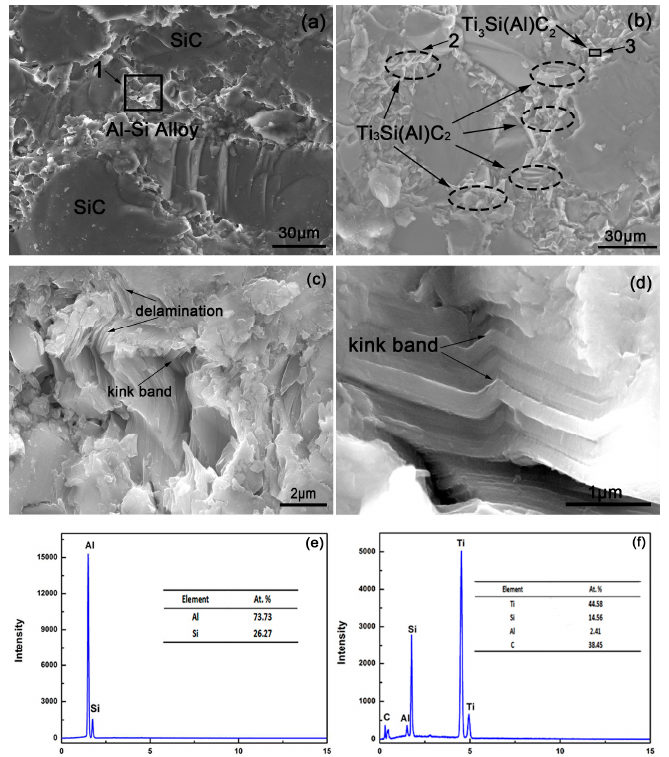
Figure 6. SEM micrographs of the fracture surface of the composites infiltrated by the Al–Si–xTi alloy (Si: 10 wt.%): ( a ) x = 0 wt.%; ( b ) x = 15 wt.%. ( c ) Higher-magnification microstructure of region 2